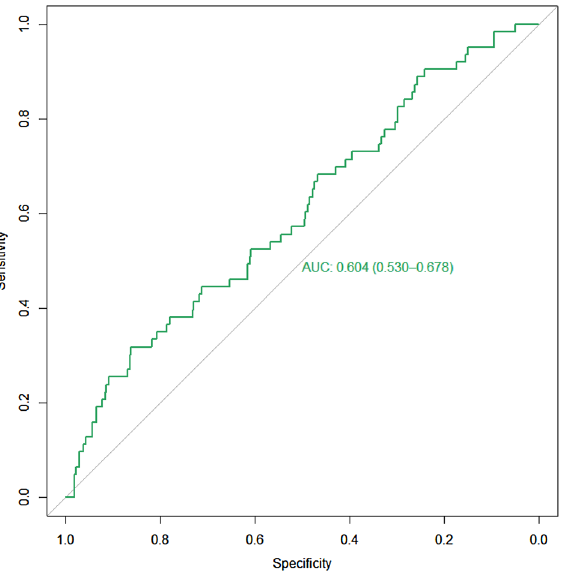
Figure 1. ROC curve for TyG index predicting mortality. TyG index of 9.15 was found to be a possible optimal cut-off point on the ROC curve (AUC: 0.604, 95% CI: 0.530–0.678, p = 0.007), predicting mortality with 33.3%